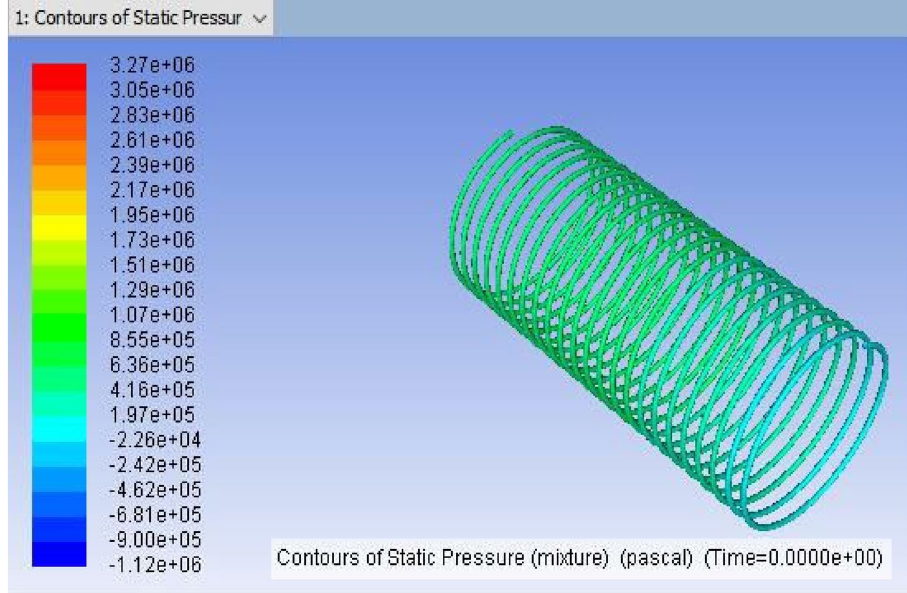
Figure 14. ANSYS Fluent solution of static pressure for capillary coil 2 (3.65 m).